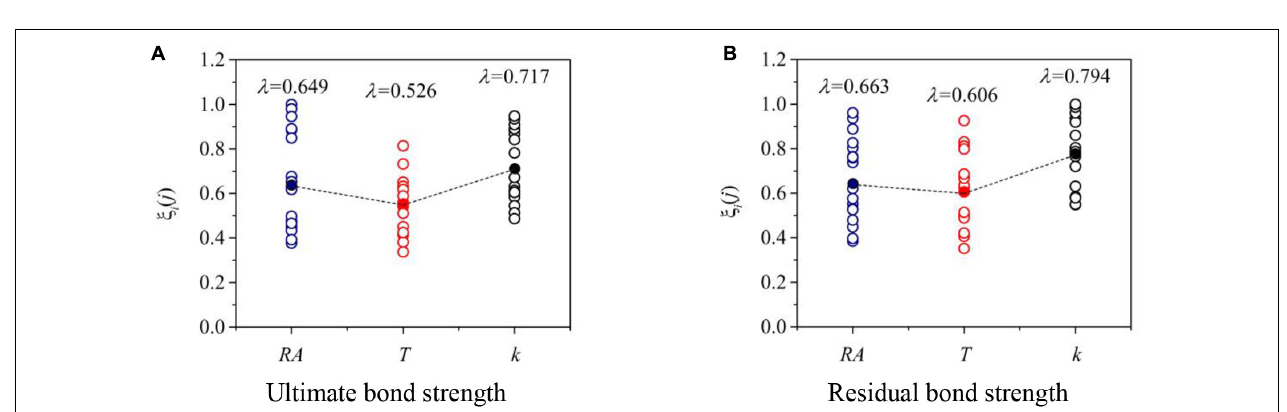
FIGURE 9 | Effect of studs. (A) The ultimate bond strength. (B) The residual bond strength. (C) The elastic bond shear stiffness.